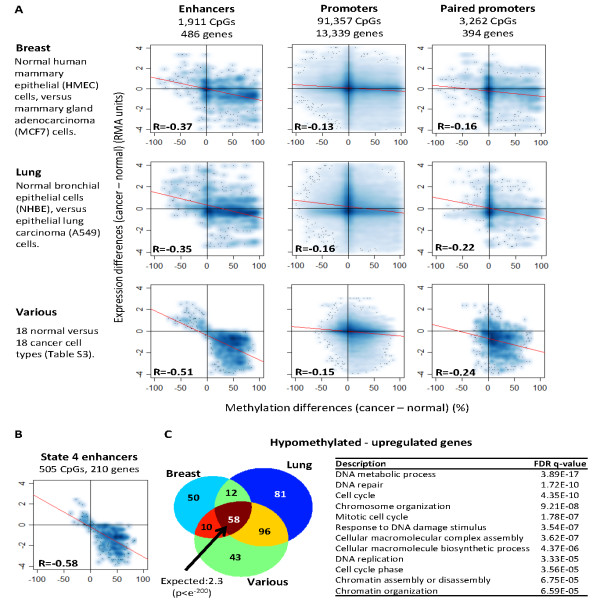
Altered enhancer methylation predicts changes in the expression profiles of cancer genes. (A) Each of the x-y scatters shows the difference in gene expression between normal and cancer cells as a function of the difference in methylation levels (for example, a difference of +100 indicates that the given site was 0% methylated in the normal cells and 100% methylated in the cancer). The plots on the left are for high-scoring enhancer sites associate with 486 genes,the right plots show the promoters of 394(out of 486) genes that were associated with enhancers, and theplots in the middle show all promoters.Blue dots and clouds donate the frequencies of methylation-versus-expression differences. Linear regression (red lines) and Pearson coefficients (R values) are shown for each scatter. (B) Same as in A, but for the 505methylation sites (out of the 1,911) in state 4 enhancers. (C)Left:Overlap between the genes (score ≥0.85) in the upper-left quadrants (that is, genes thatwere upregulated by ≥0.25 expression units withdistal enhancers that were hypomethylated by ≥25%) in breast, lung, and the collection of 18 normal versus cancer cell types. The numbers of overlapping genes are indicated. Right: Examples of GO groups that significantly enriched among the 207 genes that were upregulated and hypomethylated in the various cancer types (the entire list is provided in Table S4 in Additional file 1).